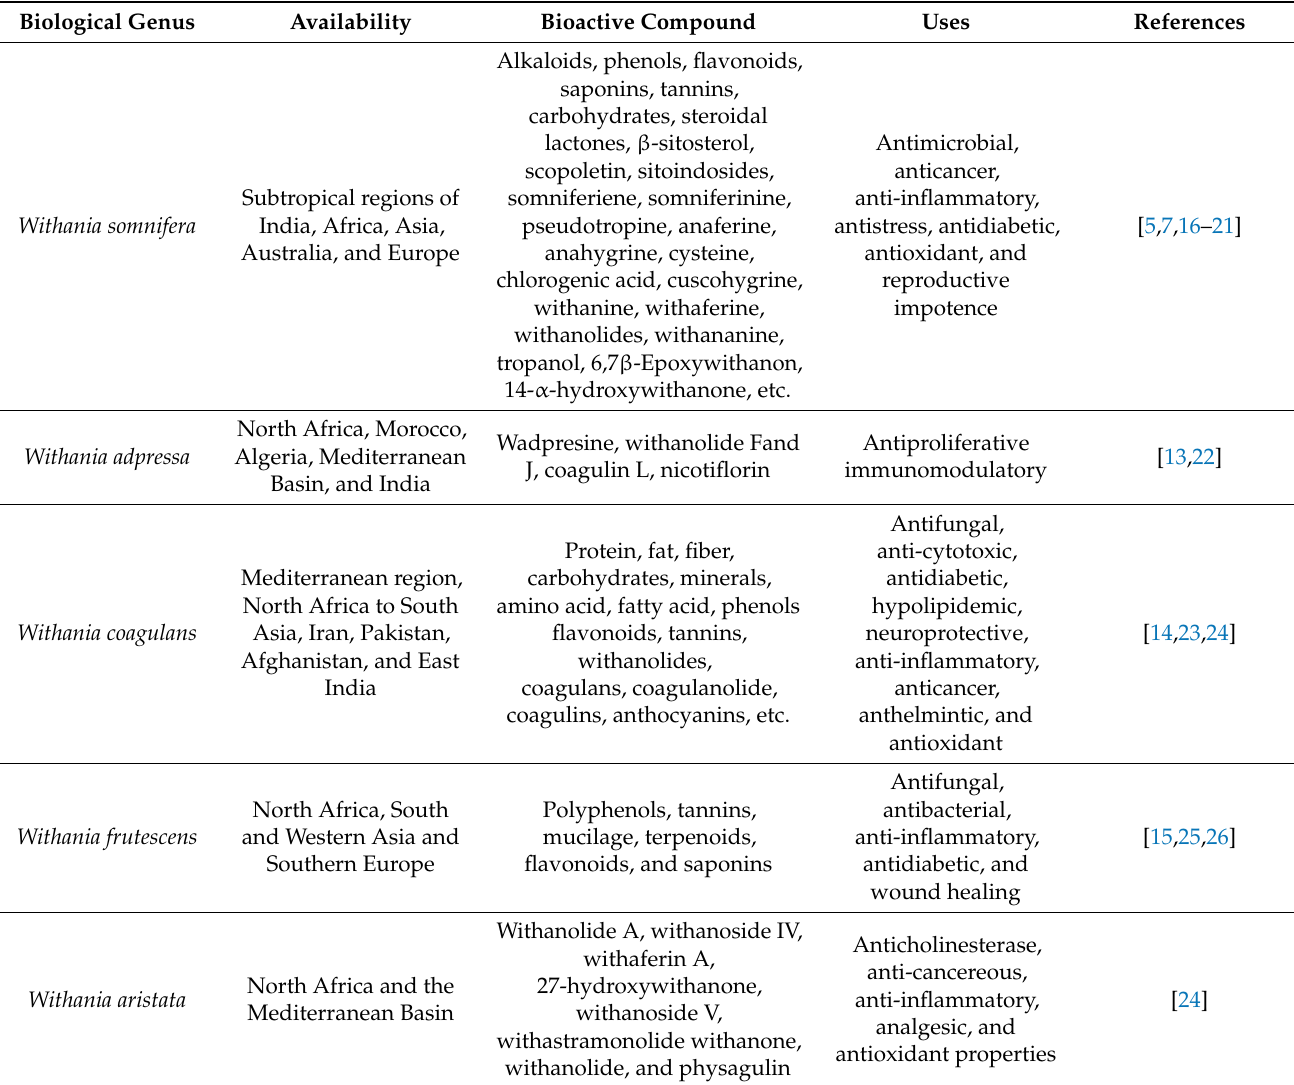
Table 1. The different biological species of the Withania genus, their availability throughout the world, and different bioactive